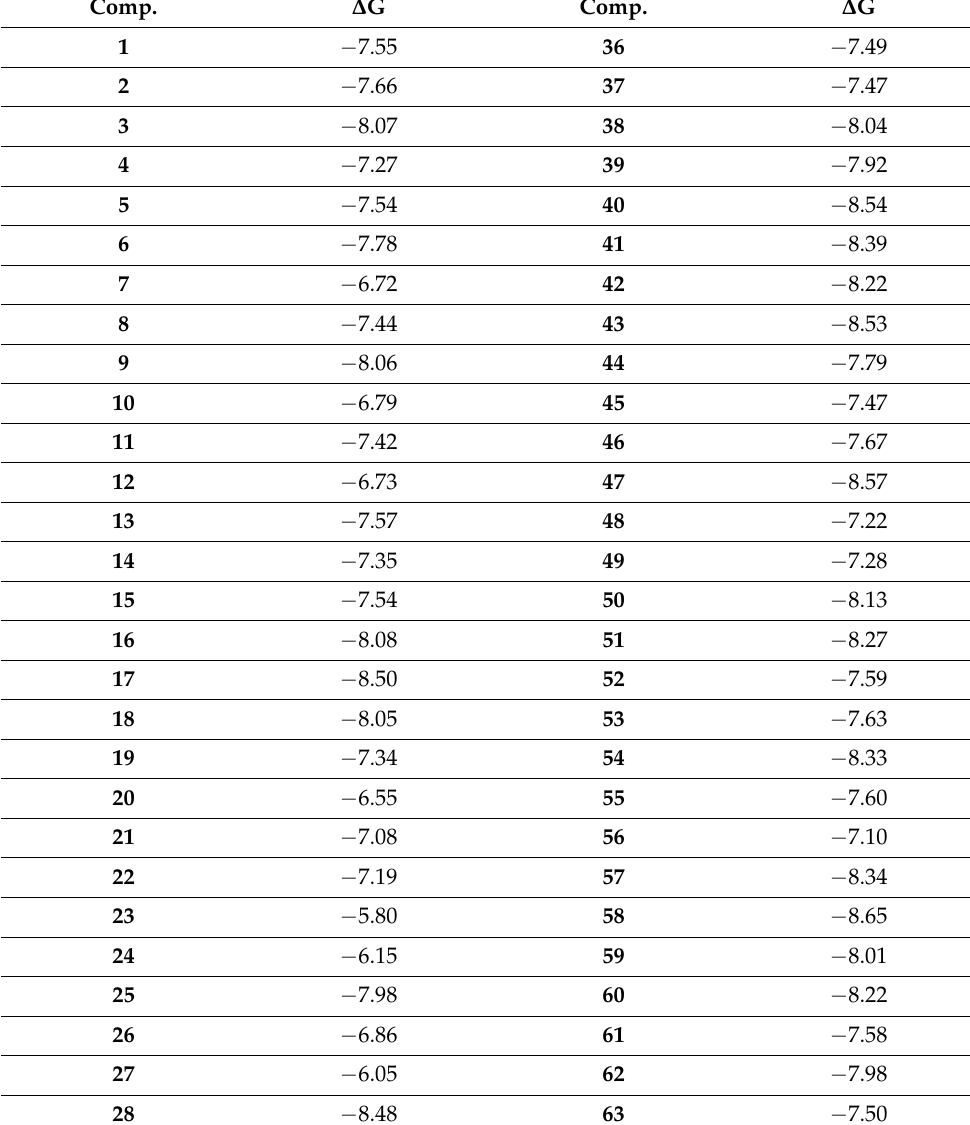
Table 1. The calculated ∆ G in Kcal/mol of the semi-synthesized molecules 1 – 69 and S88 against PLpro.